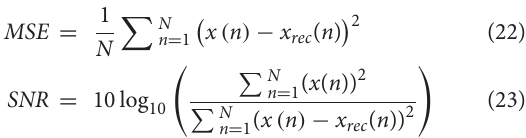
FIGURE 8 | Logarithmic energy density-averaged period plot. The red asterisks are the distribution for the IMF2-9 decomposed from an EEG signal. The groups of dots present the distribution for the white-noise